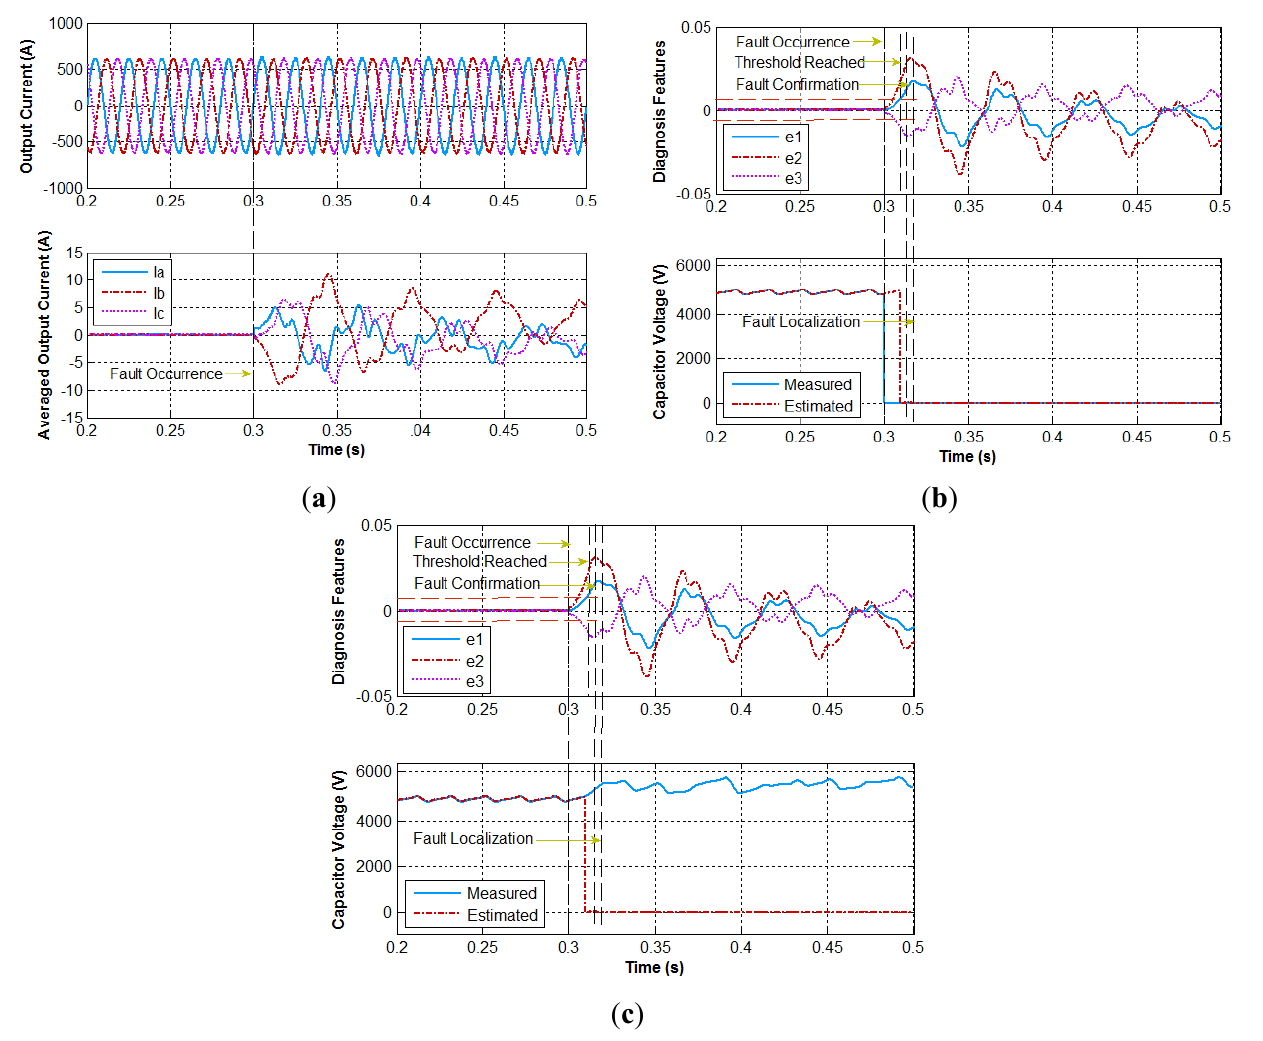
Figure 14. Short-circuit fault in T 1 or T 2 under 20 MW. ( a ) Output current and their averaged values; ( b ) Diagnosis features and capacitor voltages in SM1; ( c ) Diagnosis features and capacitor voltages in